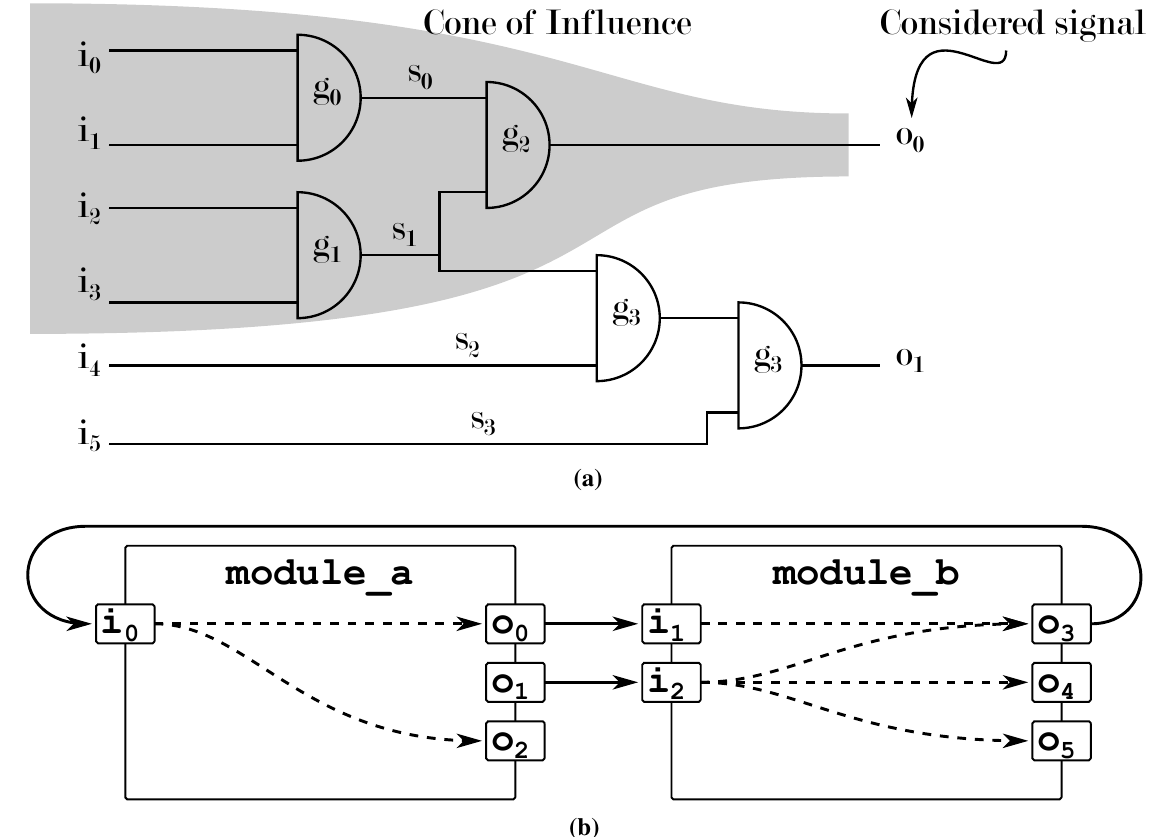
Figure 7. Cone of influence analysis allows a designer to inspect from where, e.g., a faulty signal originated. While this technique is easy to implement on, e.g., the gate level, where full netlists are available, the nature of SystemC’s black-box-like modules does not allow a simple extraction of these structures (dotted lines). ( a ) At the RTL or gate level; ( b ) at the